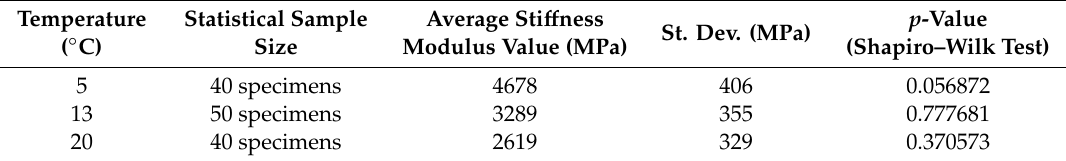
Table 3. Statistical parameters of tested ITSM values